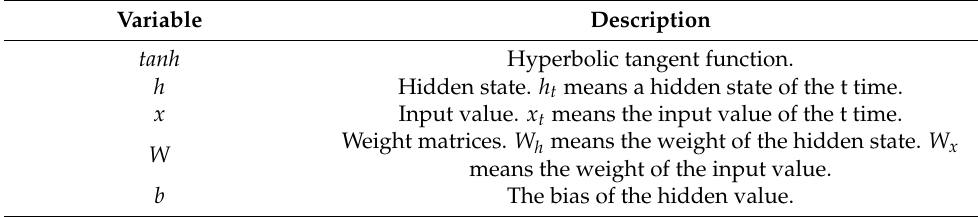
Table 4. Variables of the RNN cell.